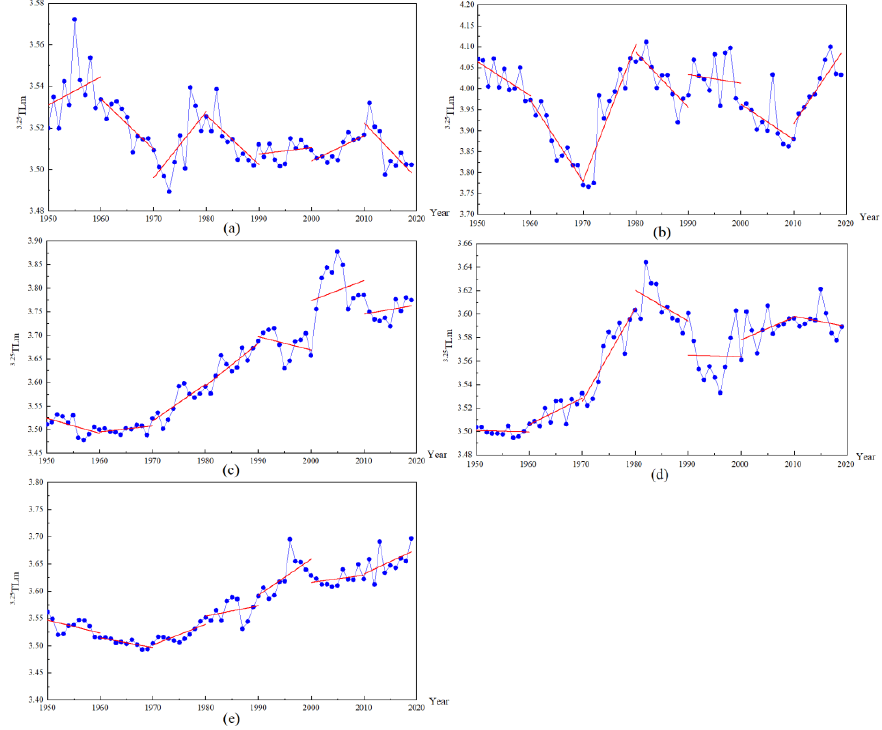
Figure 4. Trends of mean trophic level of catches with high trophic level (TL > 3.25) in Africa during 1950 – 2019: ( a ) North Africa; ( b ) East Africa; ( c ) Central Africa; ( d ) West Africa; ( e ) Southern Africa. Note: Red lines visualize the Slope, by decade. The results were calculated according to Formulas (1), (3), and (4).